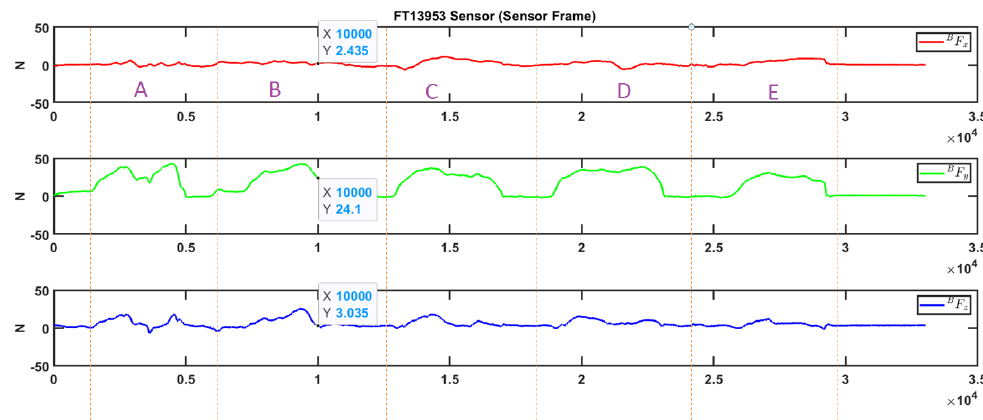
Figure 25. Experiment 5—manual pork cutting.